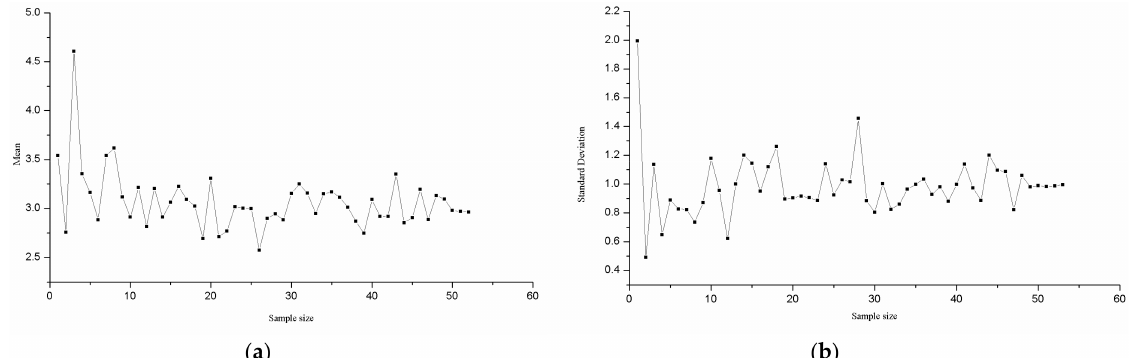
Figure 4. Variation of the statistical parameters with changing sample size of a normal distribution. ( a ) Variation of mean value x with increasing sample size; ( b ) Variation of mean variance σ with increasing sample